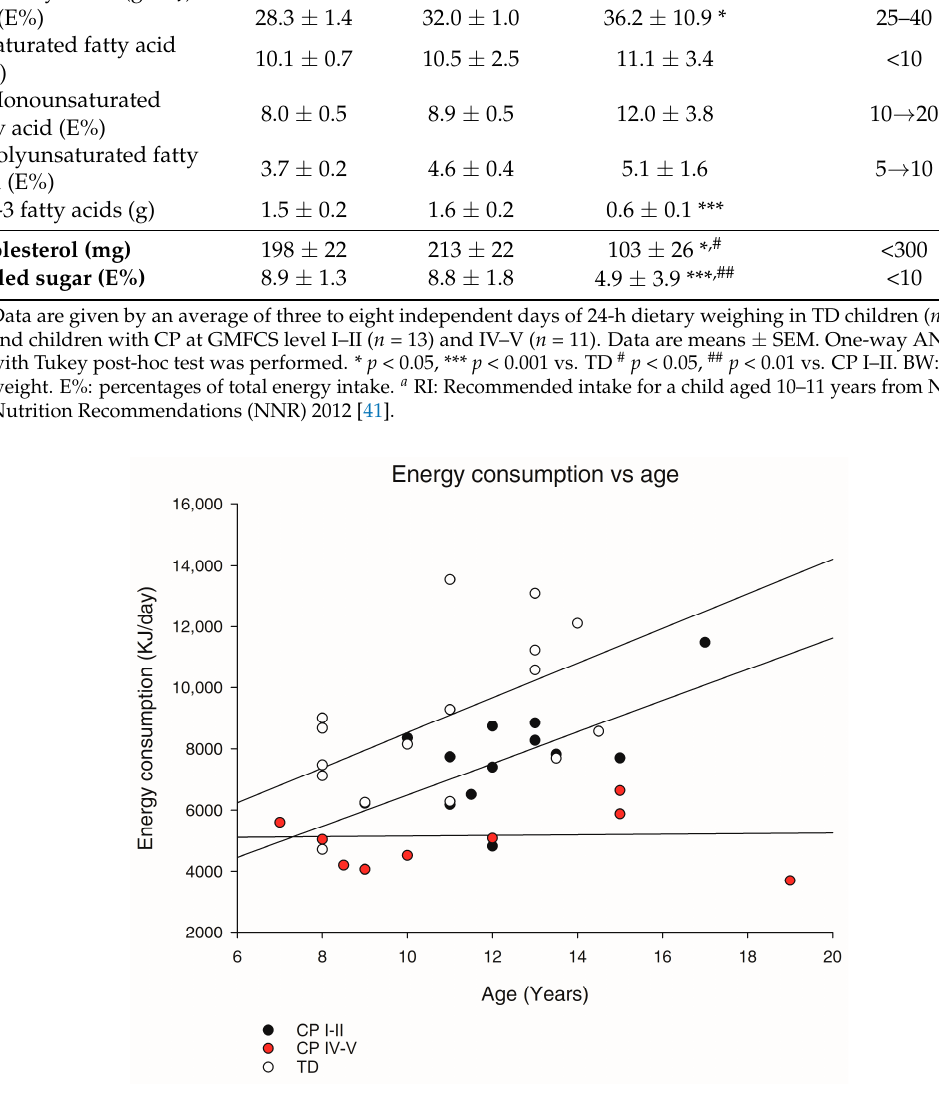
Figure 3. Scatter plot illustrating the relationship between age and energy intake in TD children ( n = 16) and children with CP at GMFCS level I–II ( n = 13) and IV–V ( n = 11). A one-way ANCOVA with Tukey post-hoc test was performed.